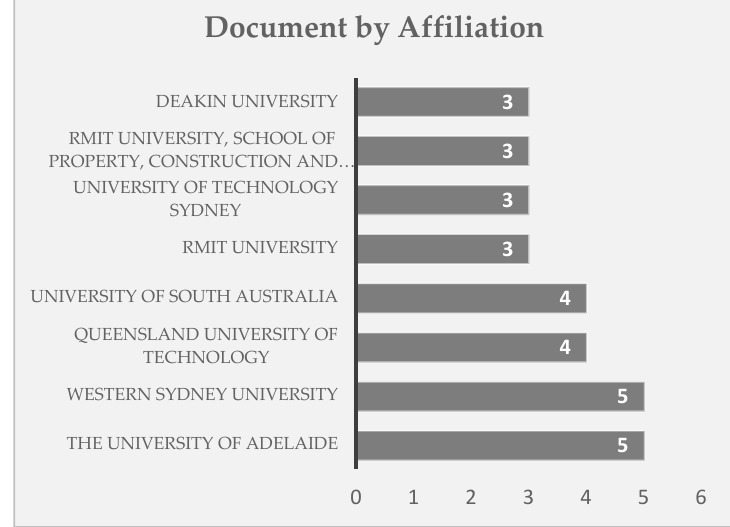
Figure 3. Documents by affiliation (affiliation with three or more articles).